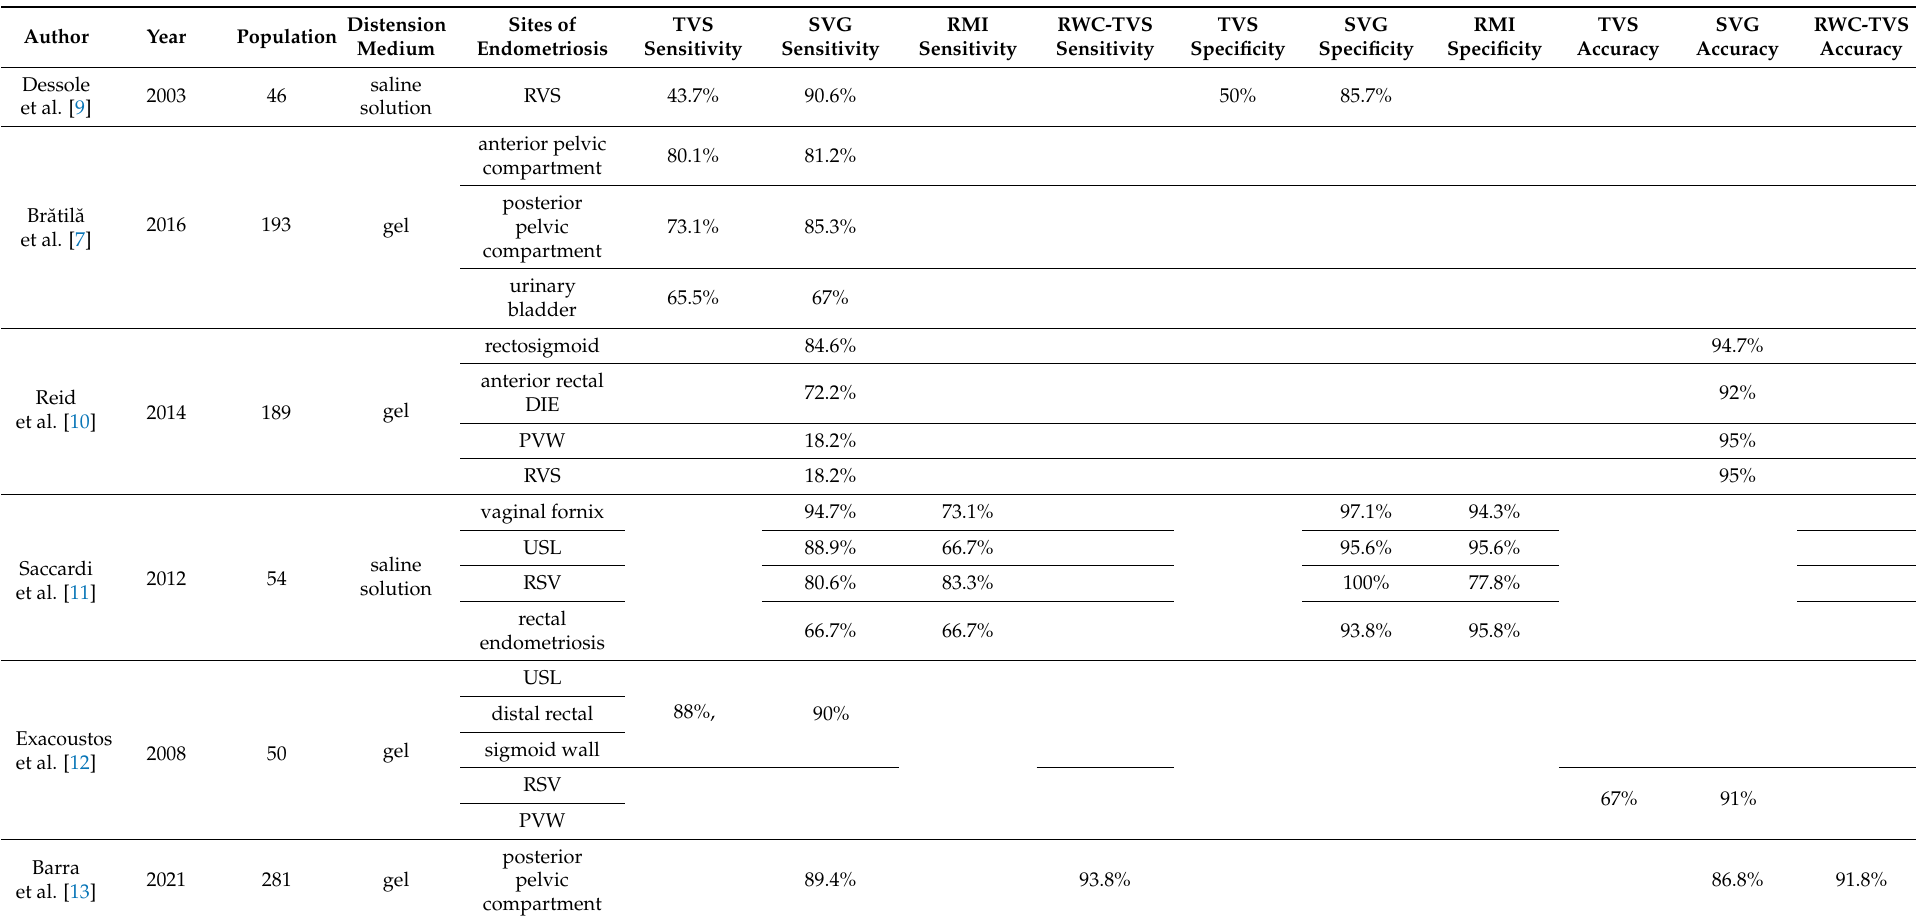
Table 1. Performance of sonovaginography in the detection of